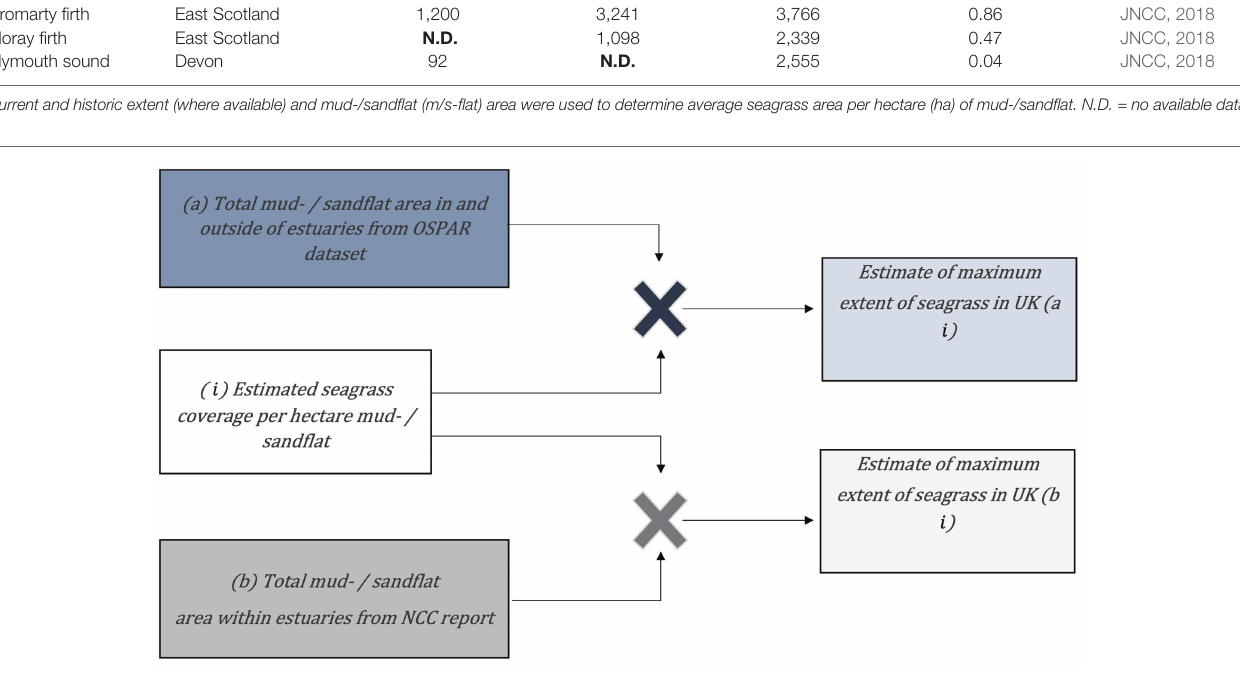
FIGURE 2 | Calculations used to estimate maximum areal extent of seagrass in mainland Britain: ; . a i ai b i bi ´ = ´ = i is the average seagrass area from 11 sites with good historic or contemporary estimates divided by known mud- and sand flat area.